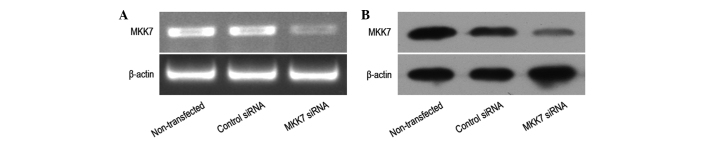
Expression of MKK7 in intestinal epithelial cells is silenced by RNA interference. (A) Interference efficiency was analyzed using reverse transcription-quantitative polymerase chain reaction following the transfection of 57 nM MKK7 siRNA into intestinal epithelial cells for 24 h. (B) MKK7-knockdown efficiency was further validated by western blotting. MKK, mitogen-activated protein kinase kinase; siRNA, small interfering RNA.